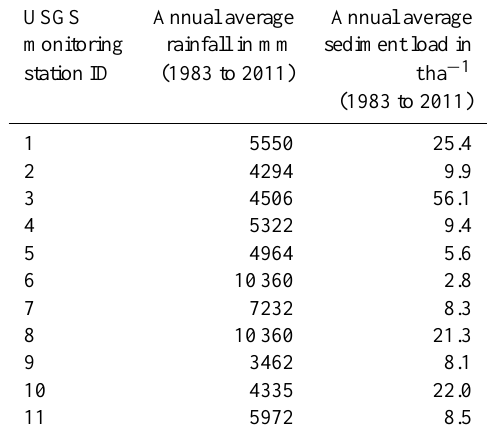
Table 7. Annual average rainfall and sediment load for each moni- toring